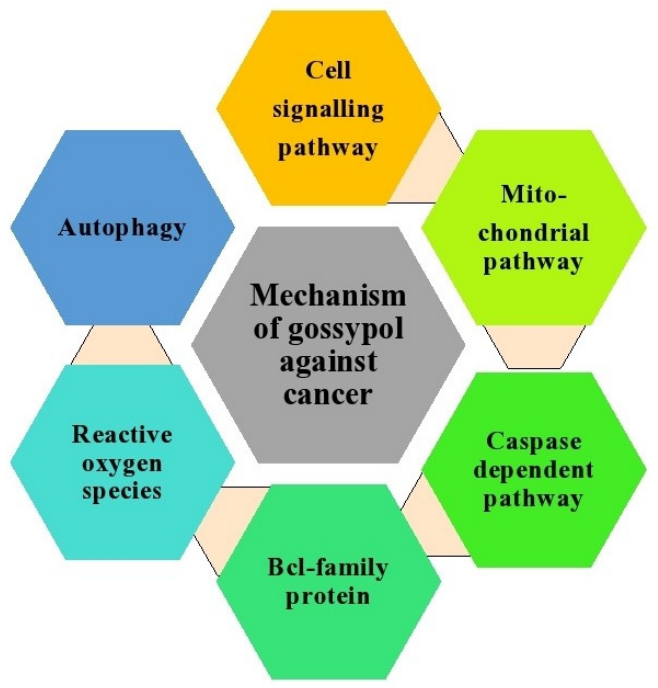
Figure 8. The molecular mechanism of actions of gossypol and its derivatives as anticancer agents.